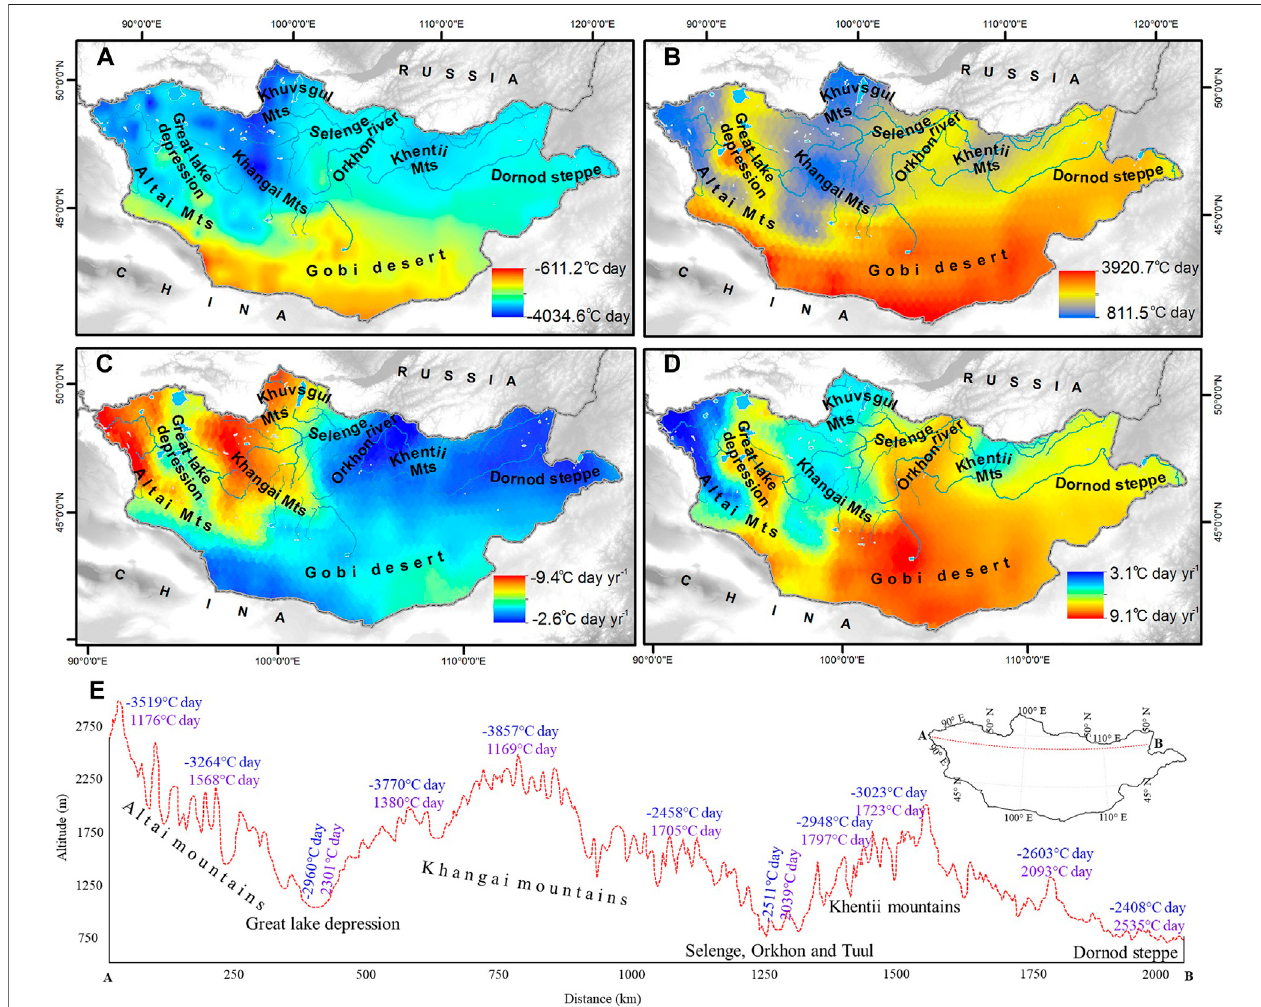
FIGURE 6 | Spatial distribution of the long-term (1960 – 2018) freezing index (A) , thawing index (B) , freezing index trend (C) , and thawing index trend (D) . (E) East- West transect through Mongolia with freezing index (blue) and thawing index (red). Elevations in m a.s.l.